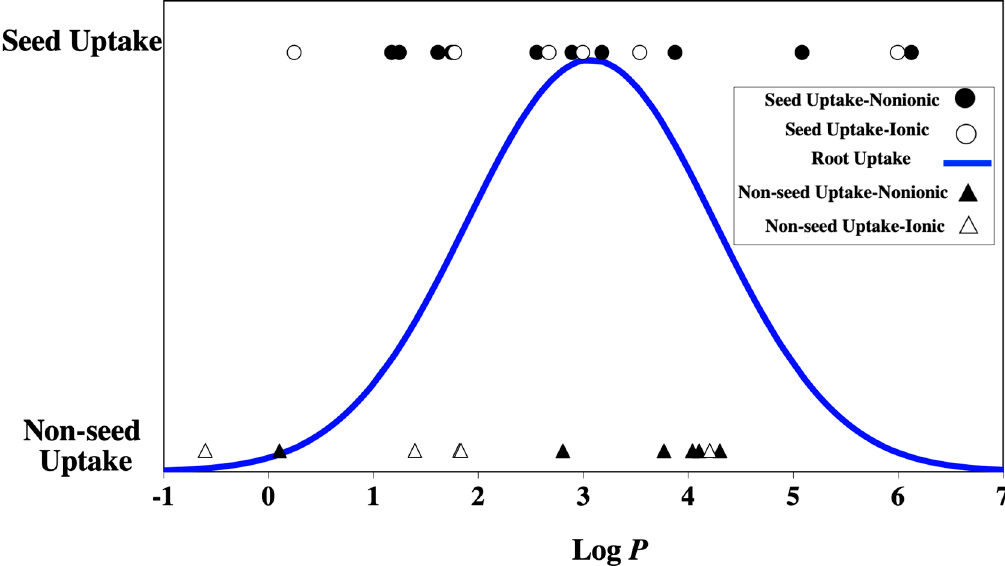
Figure 5. The log P and electrical charge of 32 tracers in relation to qualitative seed uptake or nonseed uptake. The blue line represents Gaussian distribution for systemic root uptake adapted from Hsu et al., 1990 [23].